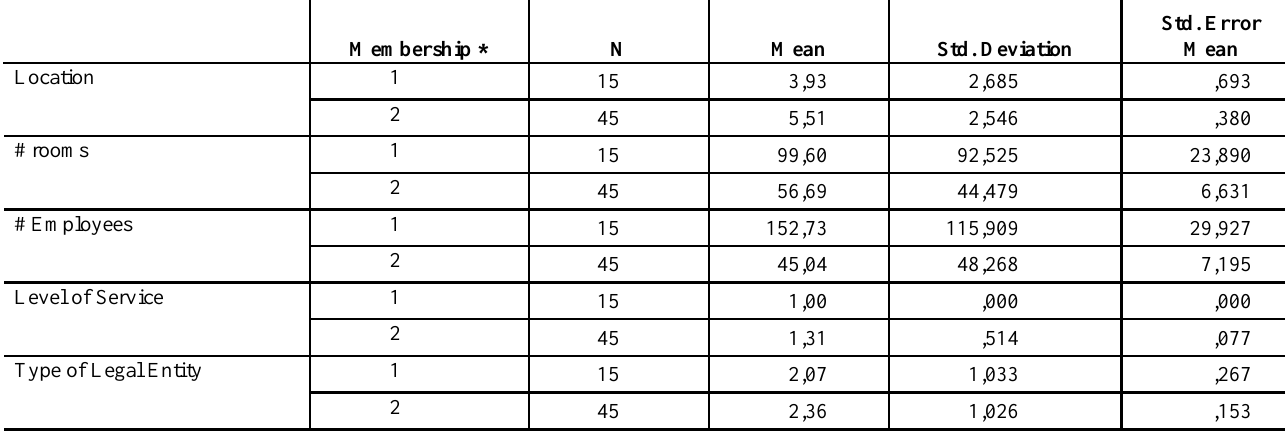
Table 1: Statistics of the sample